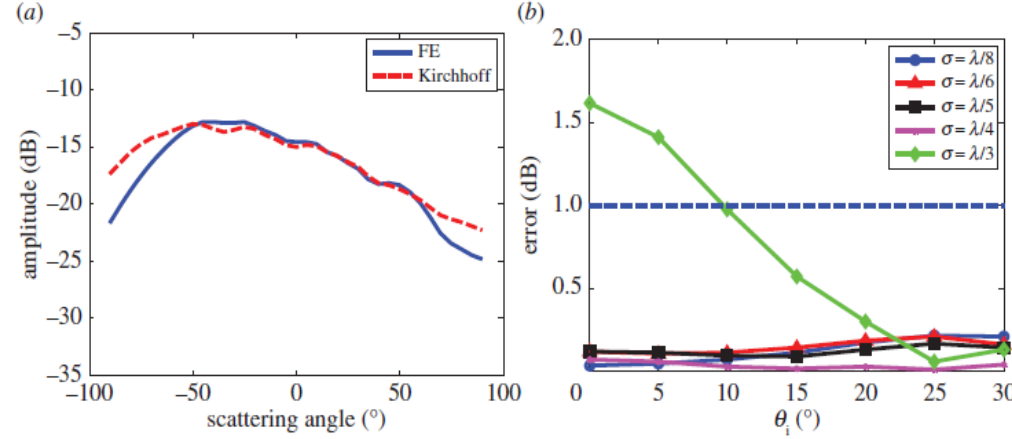
Figure 6. Shi’s Figure 12 [77]. ( a ) Shi’s Figure 11 [77]. Scattered amplitude versus observation angle using 2D FE and KA simulations, for θ i = 30 ◦ , σ = λ p / 3, L = λ p / 2 < 0.6 λ p. ( b ) Error between 2D FE